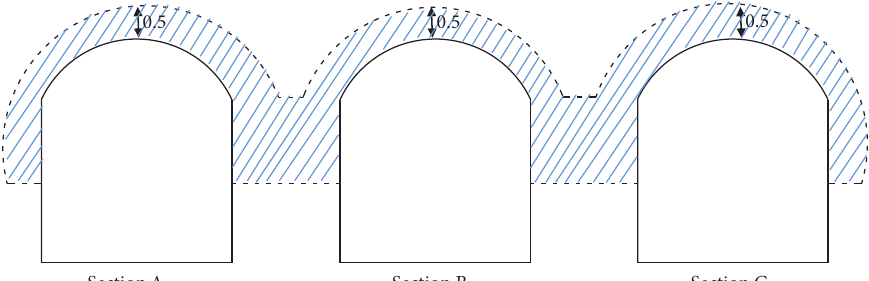
Figure 8: Reinforced section view.